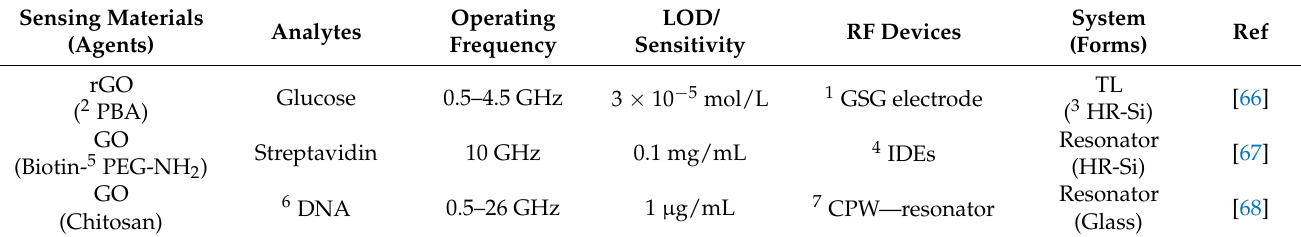
Table 3. GO/rGO-based passive RF biosensors for wireless biosensing